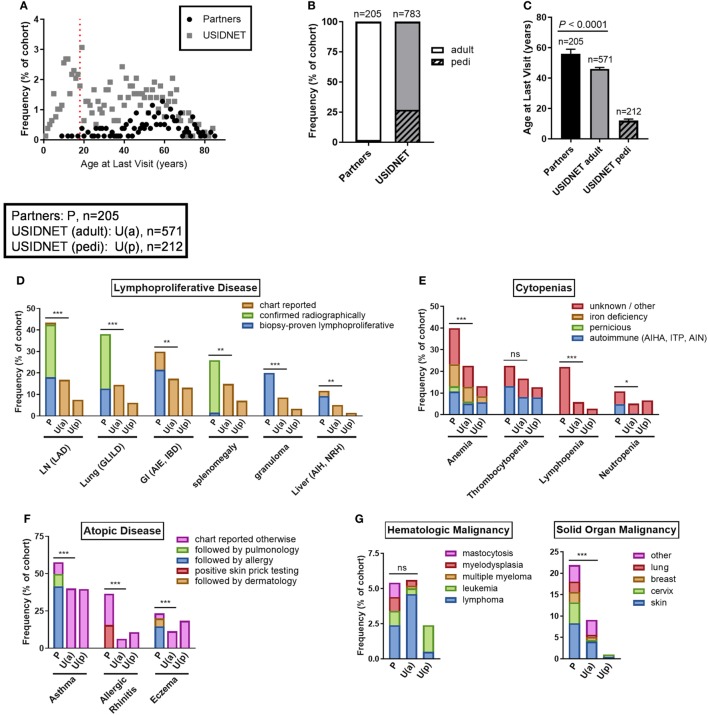
Comparative non-infectious disease complication rates between the Partners and United States Immunodeficiency Network (USIDNET) common variable immunodeficiency (CVID) cohorts. (A) Patient age at time of last visit, shown as frequency by age with dotted red line indicating the pediatric cutoff (≤18 years). (B) Adult vs. pediatric distribution at time of last visit, shown as percentage of total cohort. (C) Patient age at time of last visit, shown as median ± 95% CI with statistical significance indicated by P value. Frequency of (D) lymphoproliferative disease, (E) cytopenias, (F) atopic disease, (G) malignancy, and (H) autoimmunity, shown as percentage of total cohort with available data entry [Partners: P, n = 205; USIDNET adult: U(a), n = 571, USIDNET pediatric: U(p), n = 212]. Statistical significance between the Partners total and USIDNET adult cohorts is indicated for the total outcome represented in the bar (ns = not statistically different, *P < 0.05, **P < 0.005, ***P < 0.0001). AIE, autoimmune enteropathy; AIH, autoimmune hepatitis; AIHA, autoimmune hemolytic anemia; AIN, autoimmune neutropenia; APLS, antiphospholipid syndrome; CCP, cyclic citrullinated peptide; CIU, chronic intermittent urticaria; GI, gastrointestinal; GLILD, granulomatous-interstitial lung disease; IBD, inflammatory bowel disease; ITP, immune thrombocytopenia; LAD, lymphadenopathy; LN, lymph node; MCTD, mixed connective tissue disease; NRH, nodular regenerative hyperplasia; pedi, pediatric; PMR, polymyalgia rheumatica; RF, rheumatoid factor.